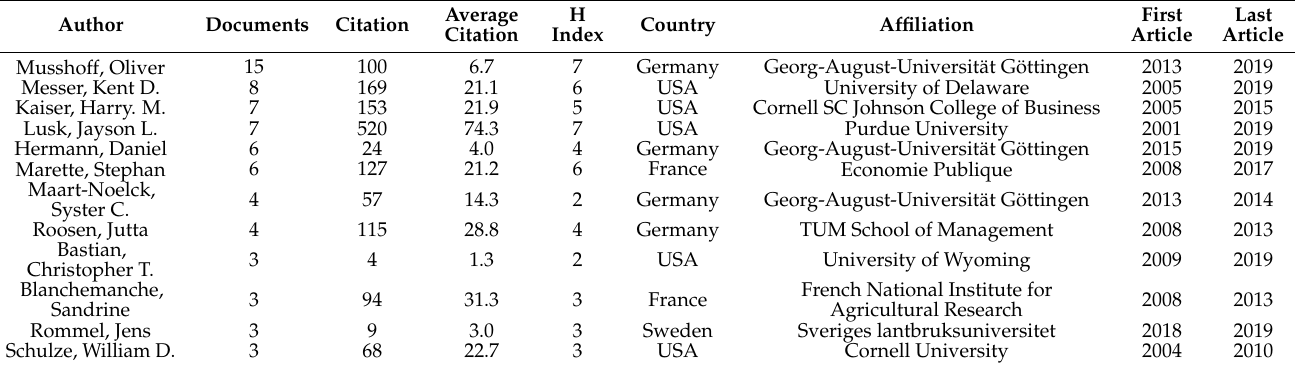
Table 7. Major characteristics of the most active authors related to EEA